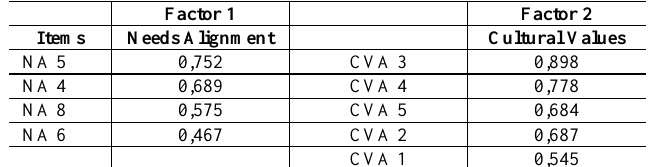
Table 1: Antecedent variables: Needs alignment and